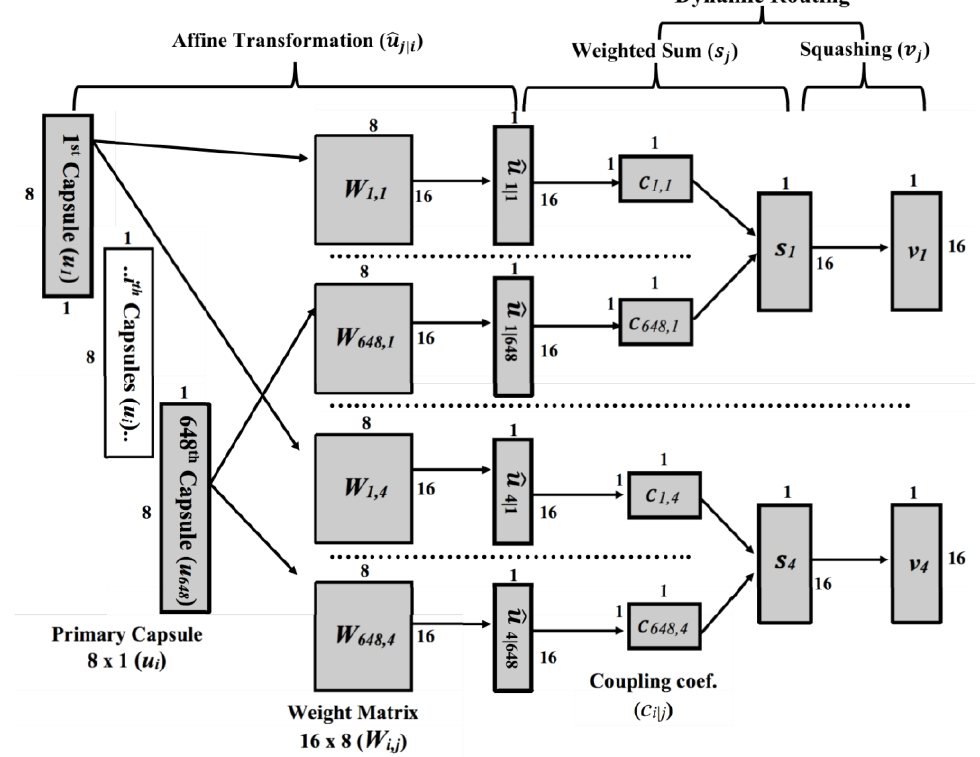
Figure 7. Illustration of the Emotion Capsules